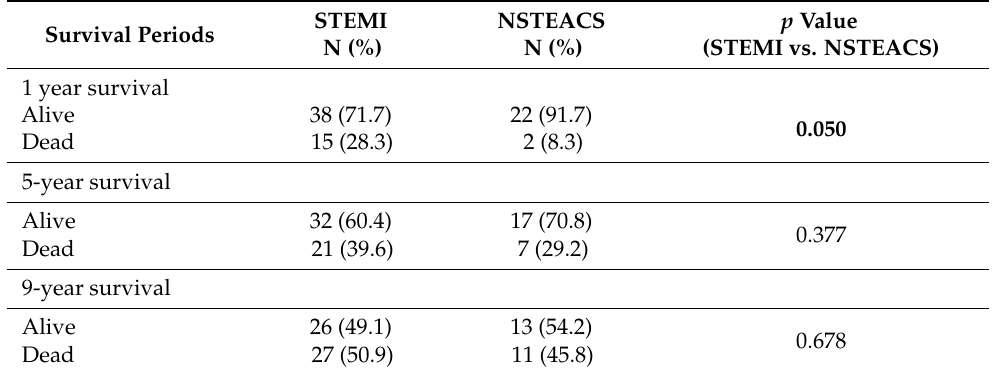
Table 6. Survival rate after one, 5 and 9 years of follow-up of patients with ACS. Survival